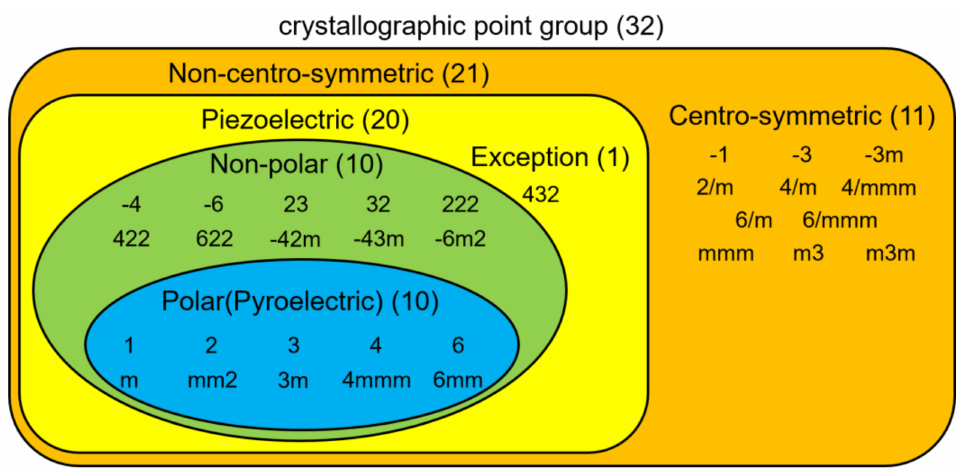
Figure 1. Classification of 32 crystallographic point